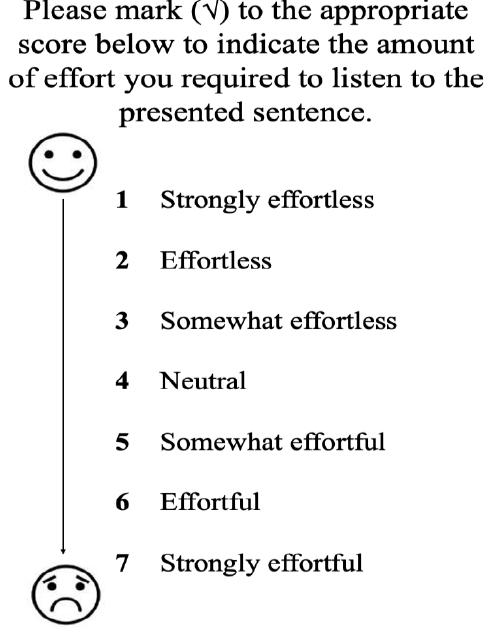
Figure A1. An example of the seven-point Likert scale questionnaire used for evaluating amount of listening effort.